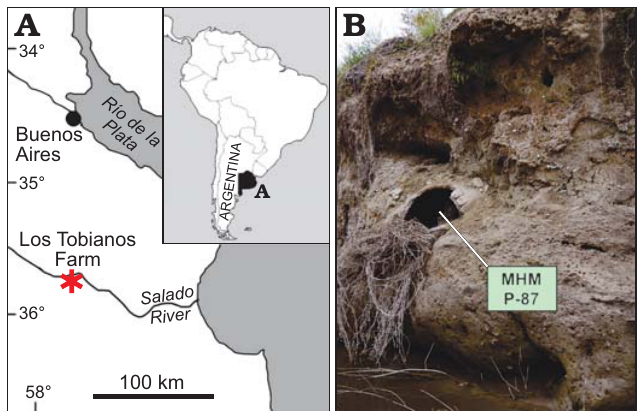
Fig. 1. A . Geographic location of studied area within Buenos Aires Prov- ince, Argentina (inset) near General Belgrano city, Los Tobianos Farm (35°45’5.52” S, 58°37’35.96” W), asterisk indicates where the studied specimen was discovered. B . Photo of the outcroup along the Salado River right bank, the site where Panochthus sp. (MHM-P 87) was found.